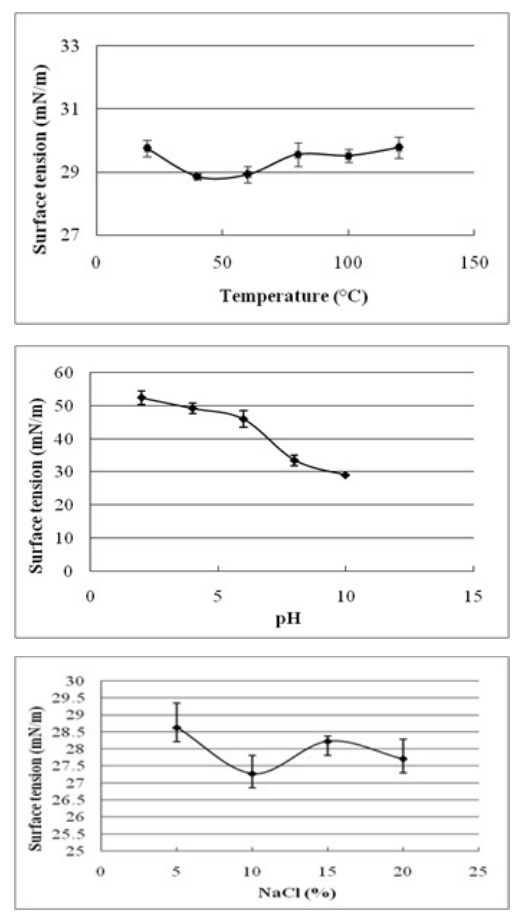
Fig. 5. Effect of (a) temperature (°C) (b) pH and (c) salinity (%) on surface tension reduction. Error bars illustrate standard error of mean (SEM), calculated from two independent experiments run in triplicates.